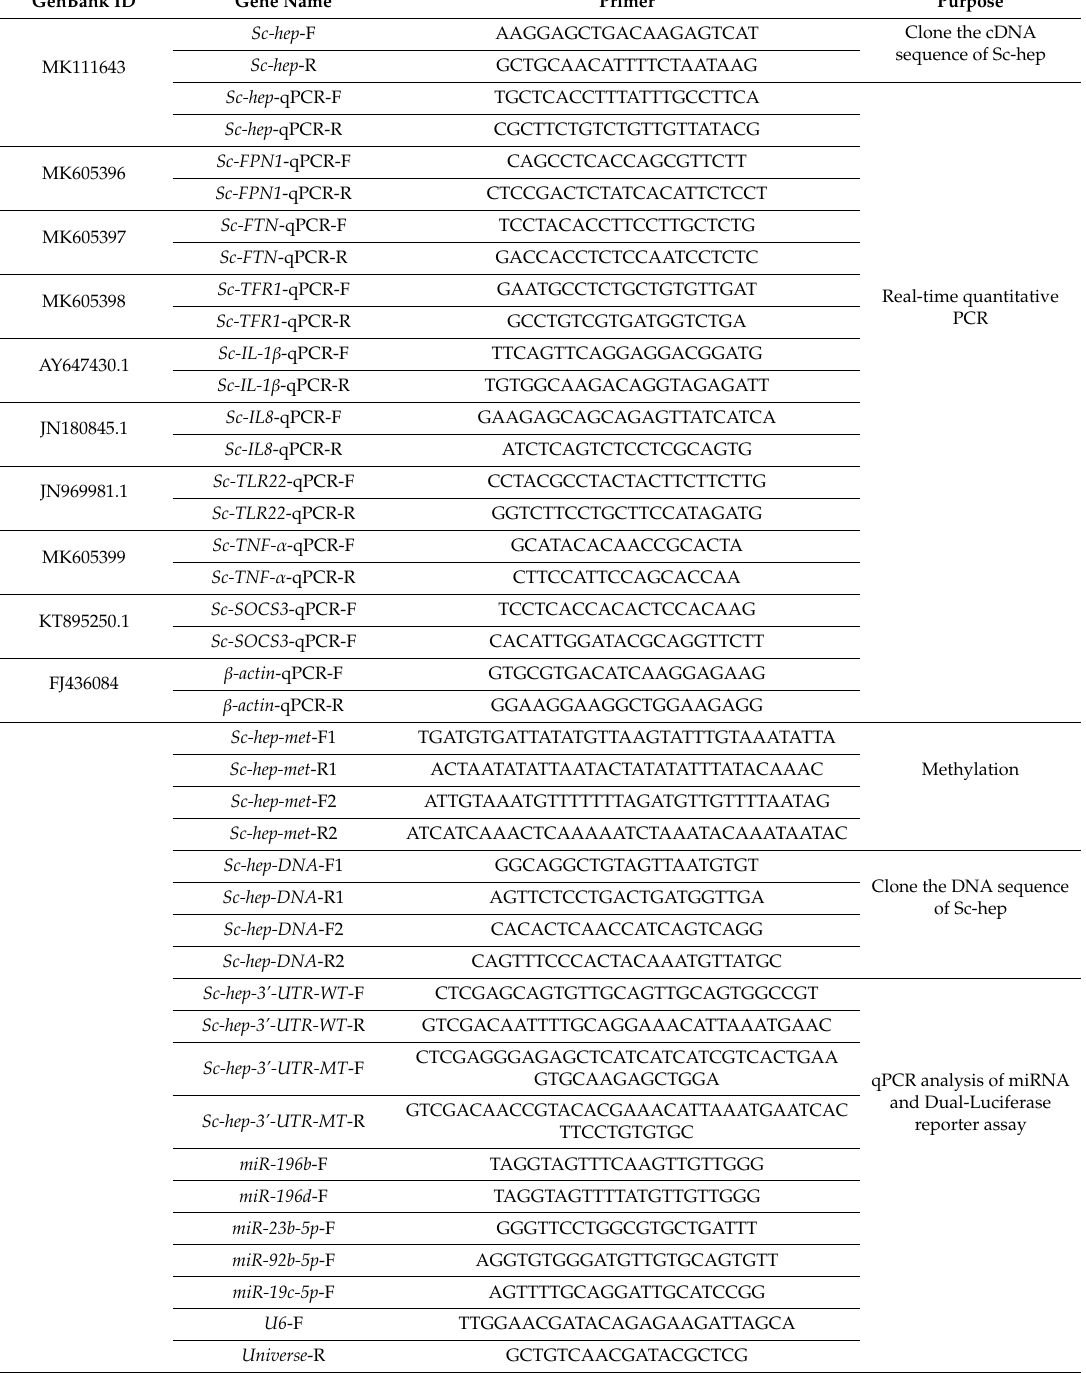
Table A2. Primers used in this